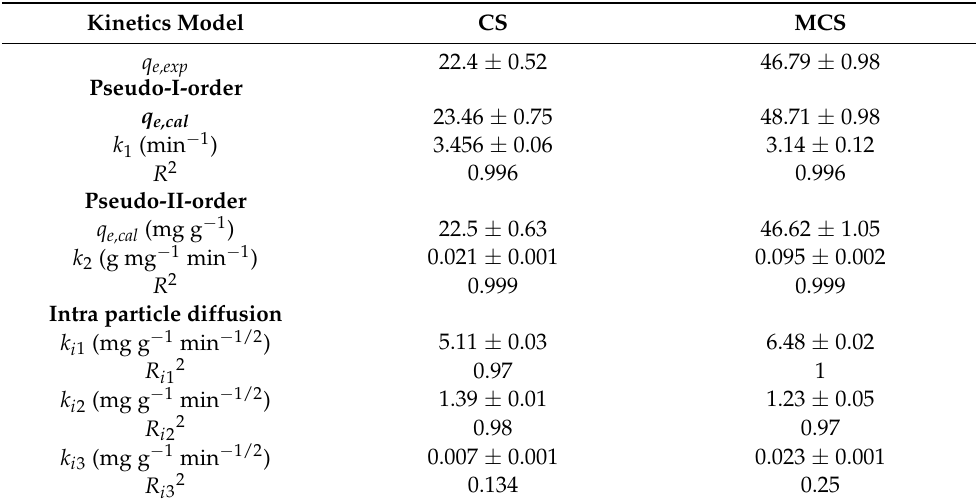
Figure 4. Kinetic models for Cd 2+ adsorption on the CS and MCS. Table 1. Kinetic parameters for Cd 2+ adsorption on the CS and MCS.